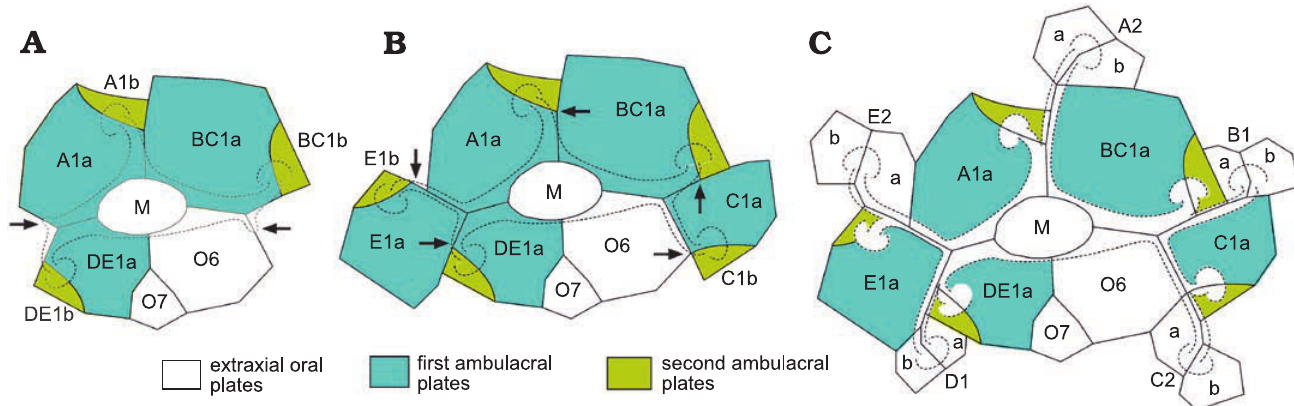
Fig. 16. Ontogenetic development of ambulacra in the callocystitid Lepadocystis moorei (Meek, 1871), Late Ordovician, Ohio, USA, showing addition of oral and ambulacral plates and development of the “BD different” pattern of primary brachioles. A . Triradiate stage with the first pair of ambulacral plates (A1a, A1b, and so on) interpreted as A, shared BC and shared DE. Arrows indicate the positions where the radial water vessels of the shared am- bulacra branch to produce a pentaradiate rhombiferan, assuming subterminal branching. B . Pentaradiate stage with a single brachiole per ambulacrum. The two new brachioles are interpreted as the first brachioles in separate ambulacra C and E. Arrows indicate positions where the radial water vessels of all five ambulacra branch to produce second brachioles. C . Pentaradiate stage with two brachioles per ambulacrum. The second brachioles in the shared ambulacra are interpreted as B1 and D1. Note that the subterminal branching has produced the “BD different” pattern of primary brachioles in which the first two brachioles in ambulacra B and D branch to the left as viewed in the growth direction, whereas in ambulacra A, C and E only the first brachiole is on the left. In addition, the second brachioles exhibit a pattern which is A right, B left, C right, D left, and E right, which equals Lovén’s Law as restated by Paul and Hotchkiss (2020). M, mouth; O6 and O7, orals 6 and 7 in the conventional interpretation of the oral circlet. Solid lines, plate sutures; dashed lines, outline of ambulacra and brachiole facets. Redrawn from Paul and Hotchkiss 2020: 1096, fig.